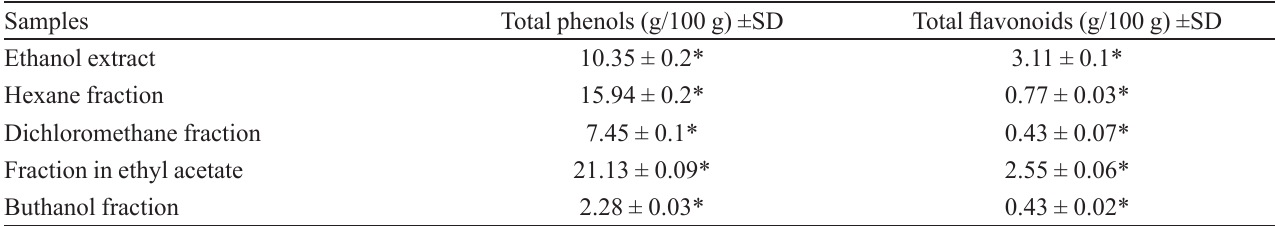
TABLE II - Phenol and flavonoid content in extracts and fractions of Rosmarinus officinalis